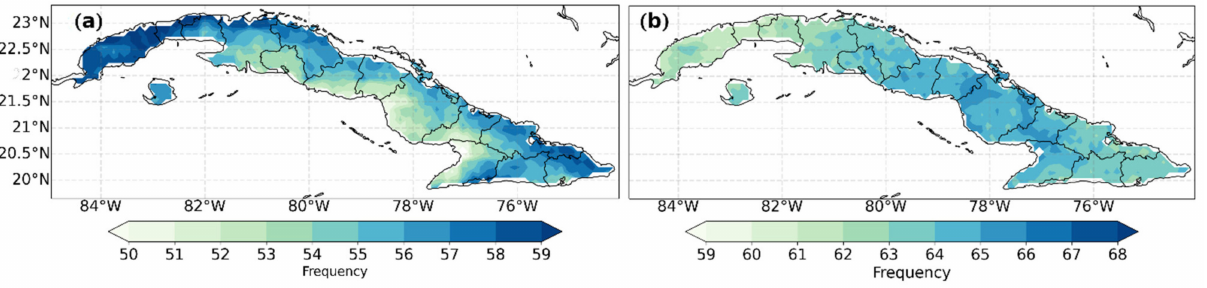
Figure 4. Mean frequency of the number of days with daily precipitation above the 95th percentile for the Dry ( a ) and Rainy ( b ) periods. Period is from 1980 to